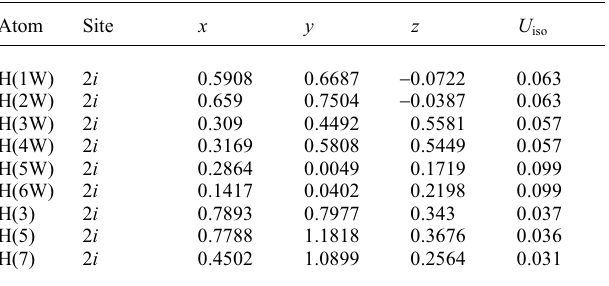
Table 2. Atomic coordinates and displacement parameters (in Å 2 )